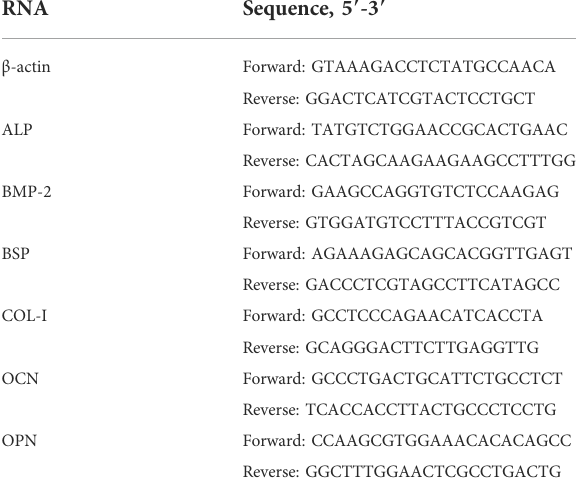
TABLE 1 Primers used in qRT-PCR.